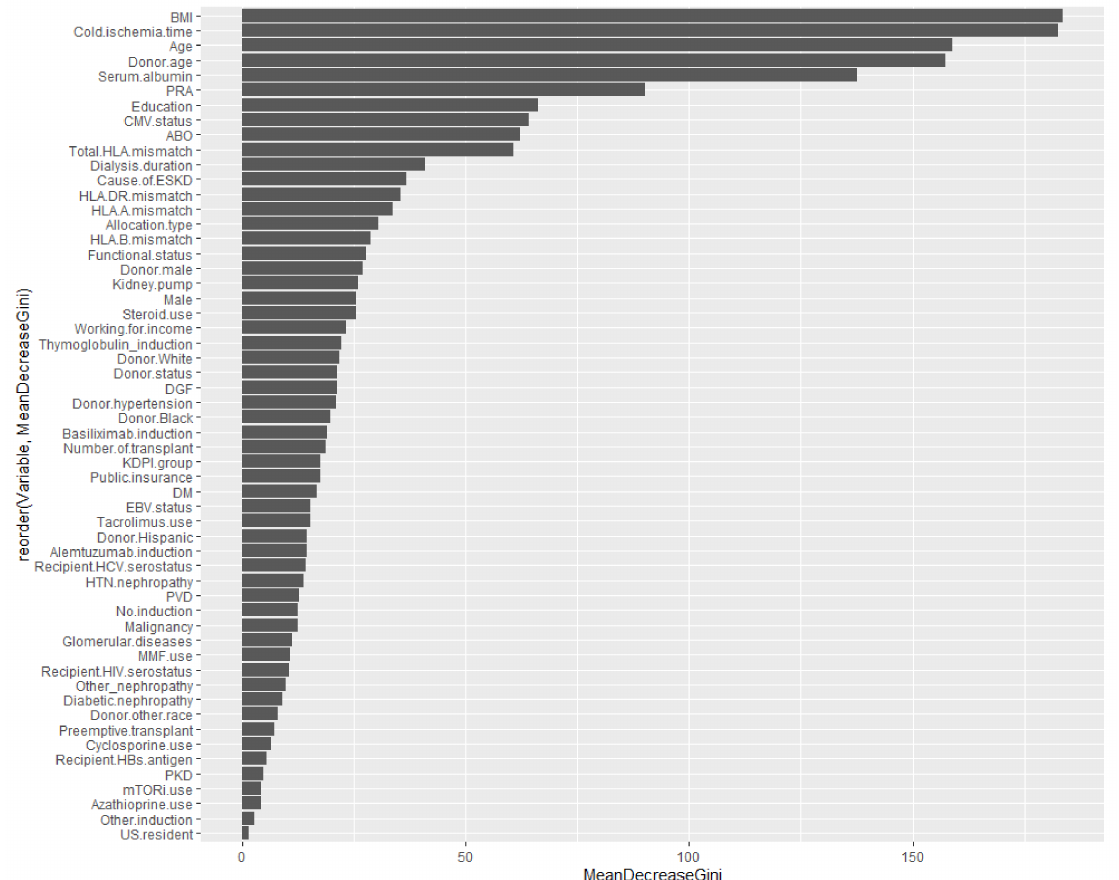
Figure 7. Variable importance summarized from Table 1 (The order of these listed variables based on mean decrease in Gini). Abbreviation: BMI—Body mass index; CMV—Cytomegalovirus; DGF—Delayed graft function; DM—Diabetes mellitus; EBV—Epstein-Barr virus; ESKD—End-stage kidney disease; HBs—Hepatitis B surface; HCV—Hepatitis C virus; HIV—Human immunodeficiency virus; HTN—Hypertension; KDPI—Kidney donor profile index; MMF—Mycophenolate, mTORi—Mammalian target of rapamycin inhibitor; PKD—Polycystic kidney disease; PRA—Panel reactive antibody; PVD—Peripheral vascular